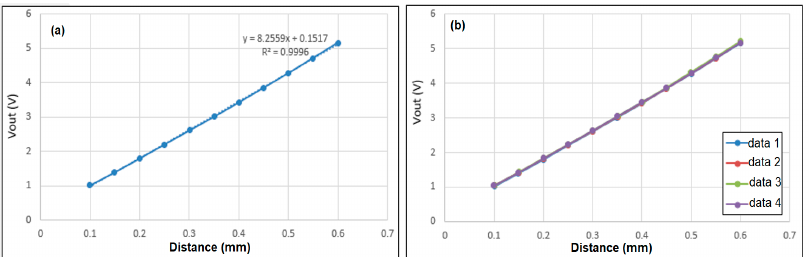
Figure 9. Correlation between output voltage and sensing distance over: ( a ) single test, and ( b ) four repeated tests.